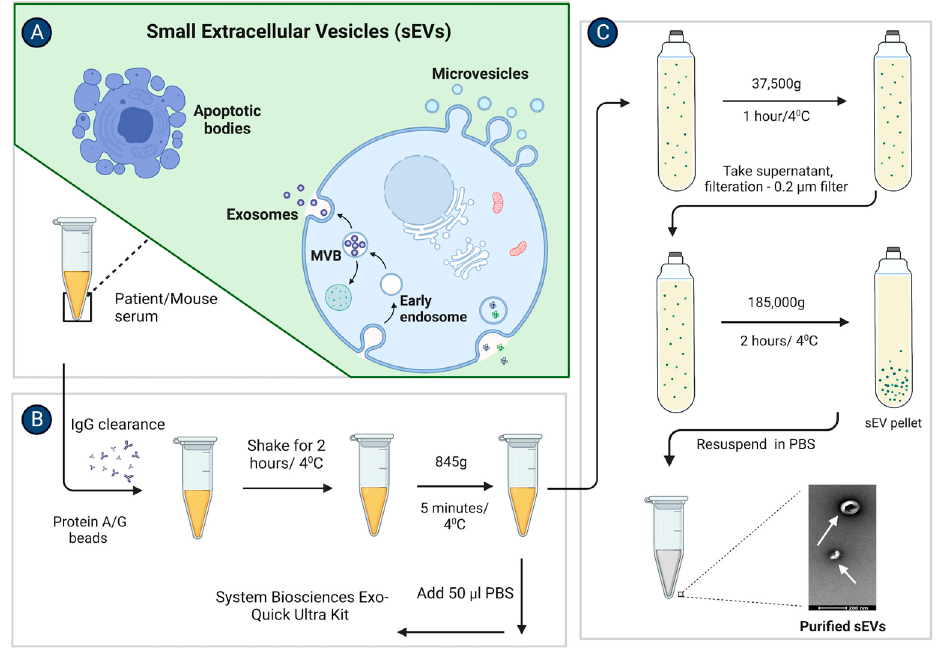
Figure 1. sEV isolation from the mouse or patient serum. Stepwise schematic illustration of the sEVs isolation protocol from a mouse and patient sera as mentioned in ( A – C ). ( A ) After collecting the serum from the blood, the serum was subjected to IgG clearance. ( B ) Briefly, samples were diluted to 250 μ L by 0.2 μ m filtered PBS. 10 μ L of Protein A/G plus agarose beads were added to the 250 μ L sample. Samples were incubated on the rotor for 2 h and centrifuged at 845× g for 5 min at 4 °C. Further samples were subjected to the ultracentrifugation or ExoQuick Ultra kit protocol for sEV isolation. ( C ) For ultracentrifugation, the sample was mixed with 70 mL of 0.2 μ m filtered PBS and was spun at 37,500× g for 1 h, and at 185,000× g for 2 h at 4 °C. The pellet was then resuspended in 100 μ L 0.2 μ m filtered PBS. For sEV isolation with the ExoQuick Ultra kit, the sample was first diluted with 50 μ L of 0.2 μ m filtered PBS and was spun at 10,000× g for 15 min. Further supernatant was subjected to an ExoQuick Ultra kit protocol. (Adapted from “Extracellular Vesicle Separation by Density Gradient Ultracentrifugation”, by BioRender.com (2020). [Retrieved from https://app.biorender.com/biorender-templates (20 December 2022)].